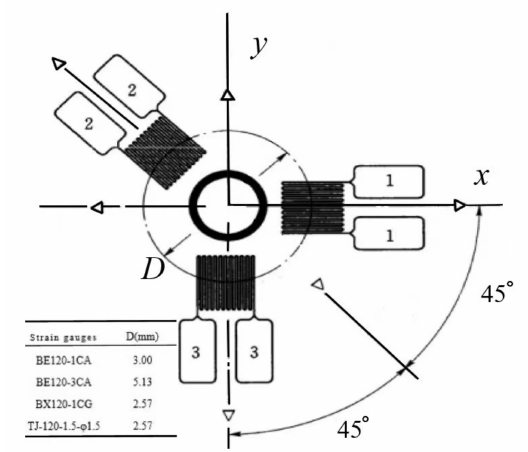
Figure 6. Variation curve of elastic strain and plastic strain at the measuring position.